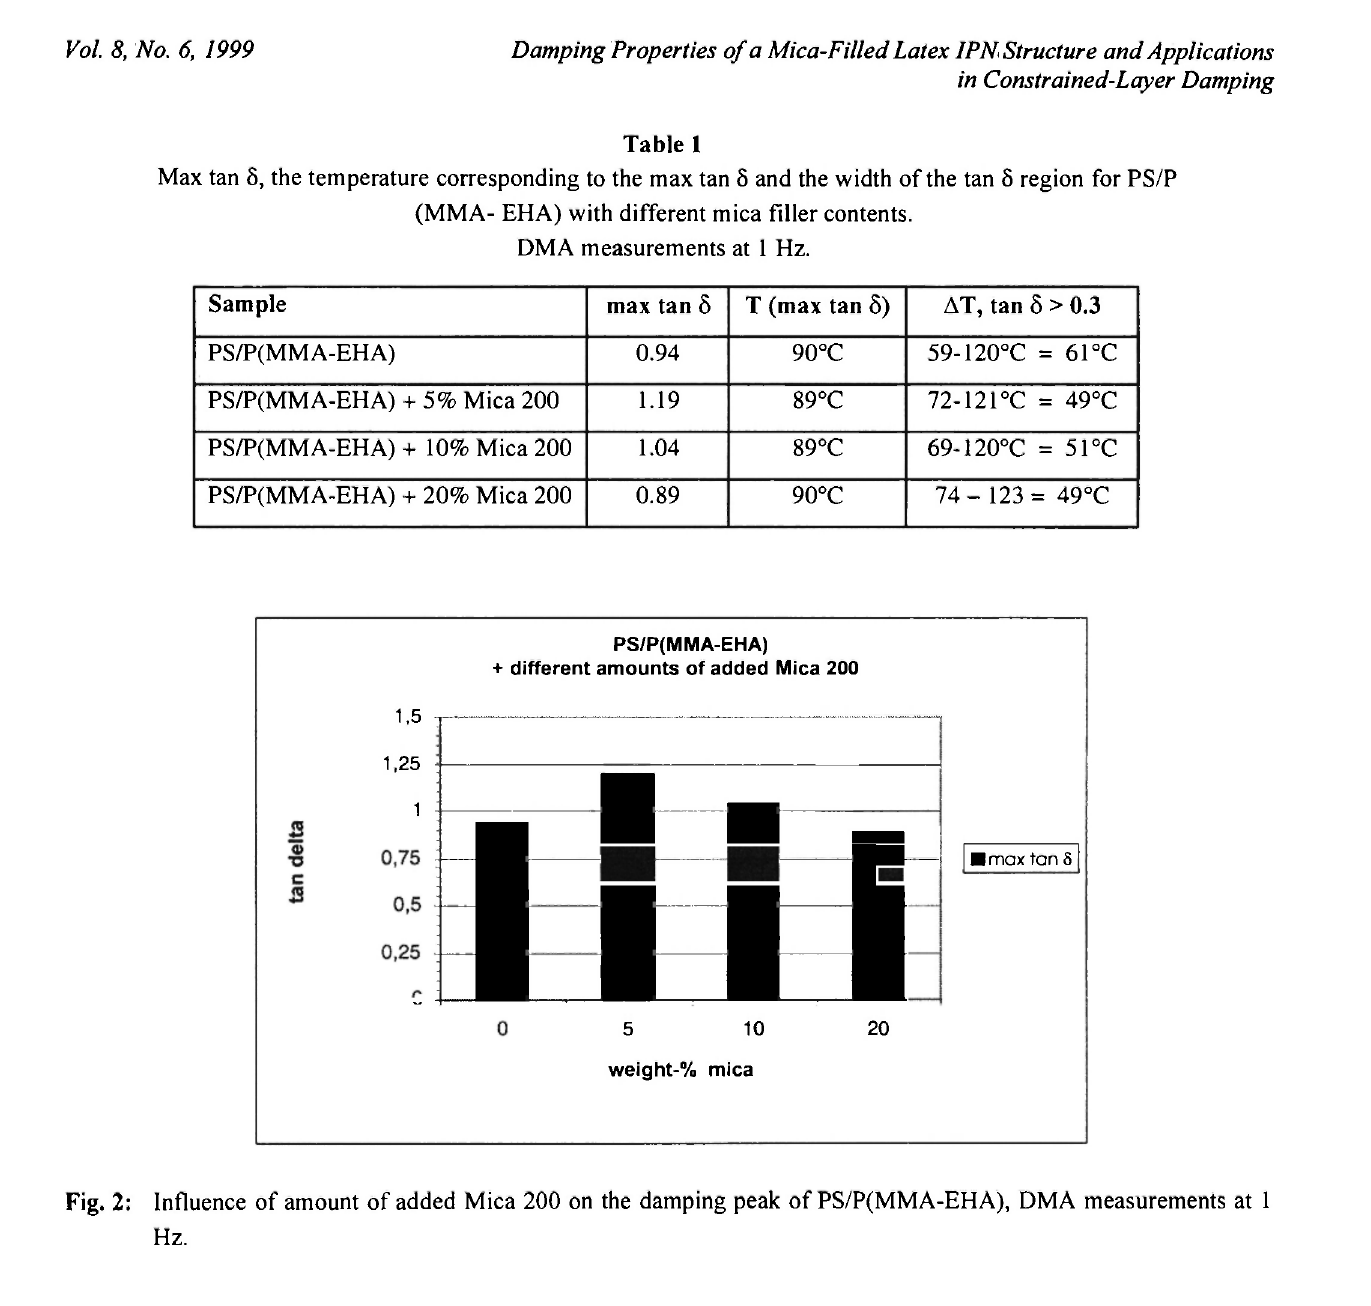
Max tan δ, the temperature corresponding to the max tan δ and the width of the tan δ region for PS/P (MMA- EHA) with different mica filler contents. DMA measurements at 1 Hz.